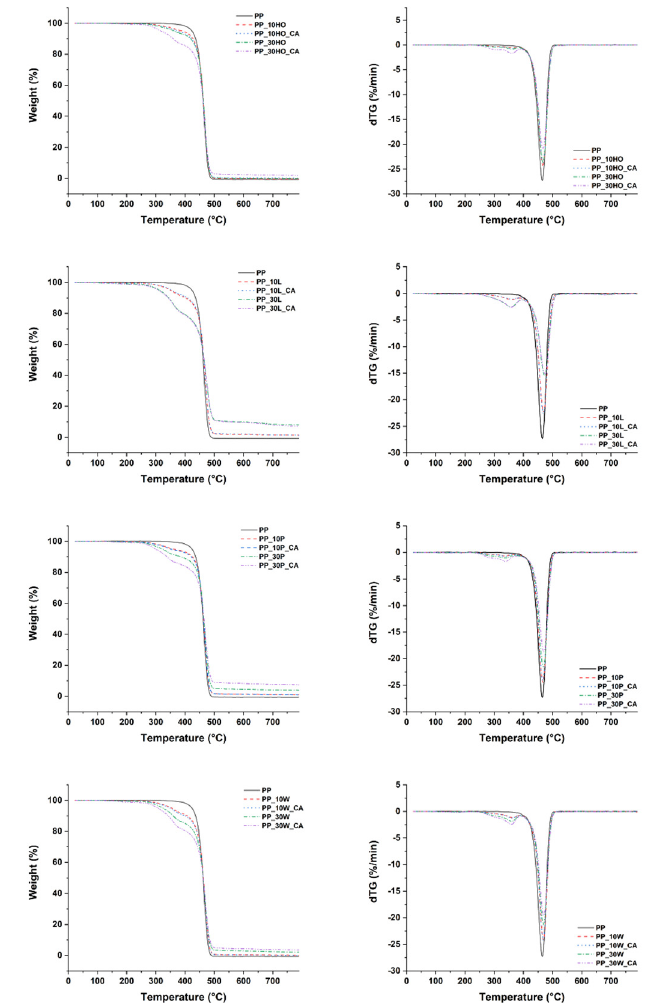
Figure 5. TGA ( left ) and dTG ( right ) curves of PP-based composites. Average parameters for thermal degradation, such as onset temperature at 5% weight loss (T d5 ), temperature at 10% weight loss (T d10 ), and maximum degradation temperature (T max ) are summarized in Table 4. Table 4. Thermal parameters obtained from Figure 5.